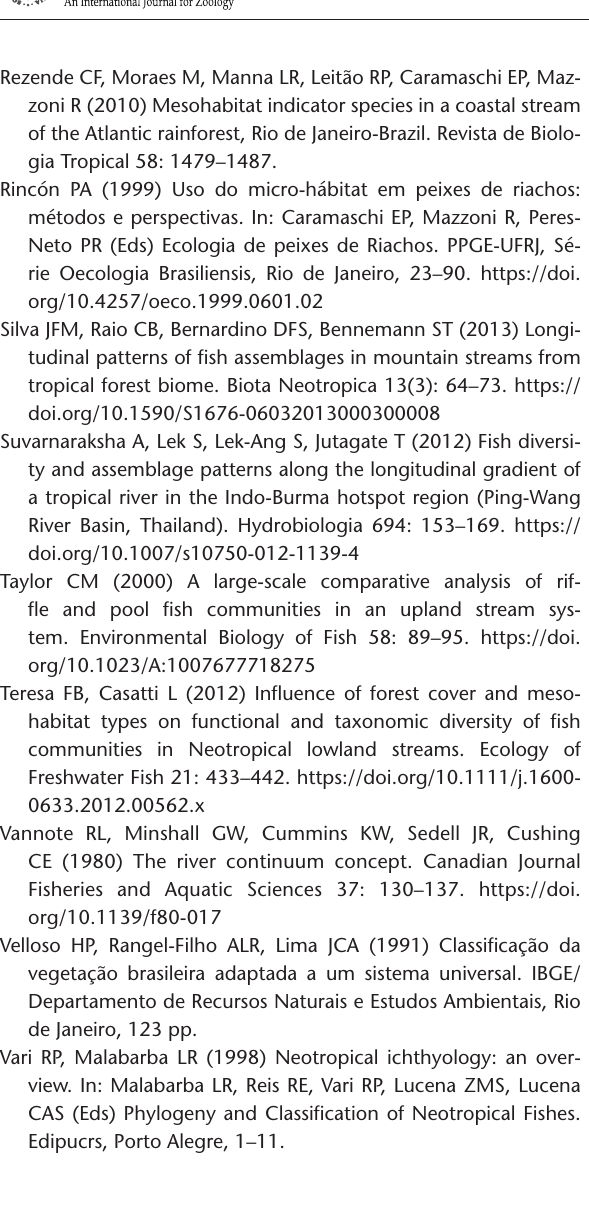
Figure S1. Hydrological and structural characteristics of the sampling reaches of the Vermelho River, state